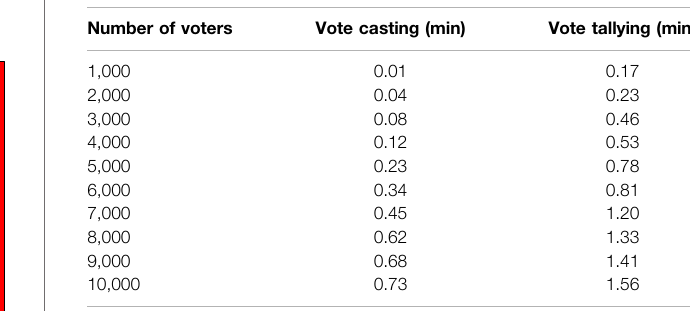
TABLE 1 | System Response Time for various user